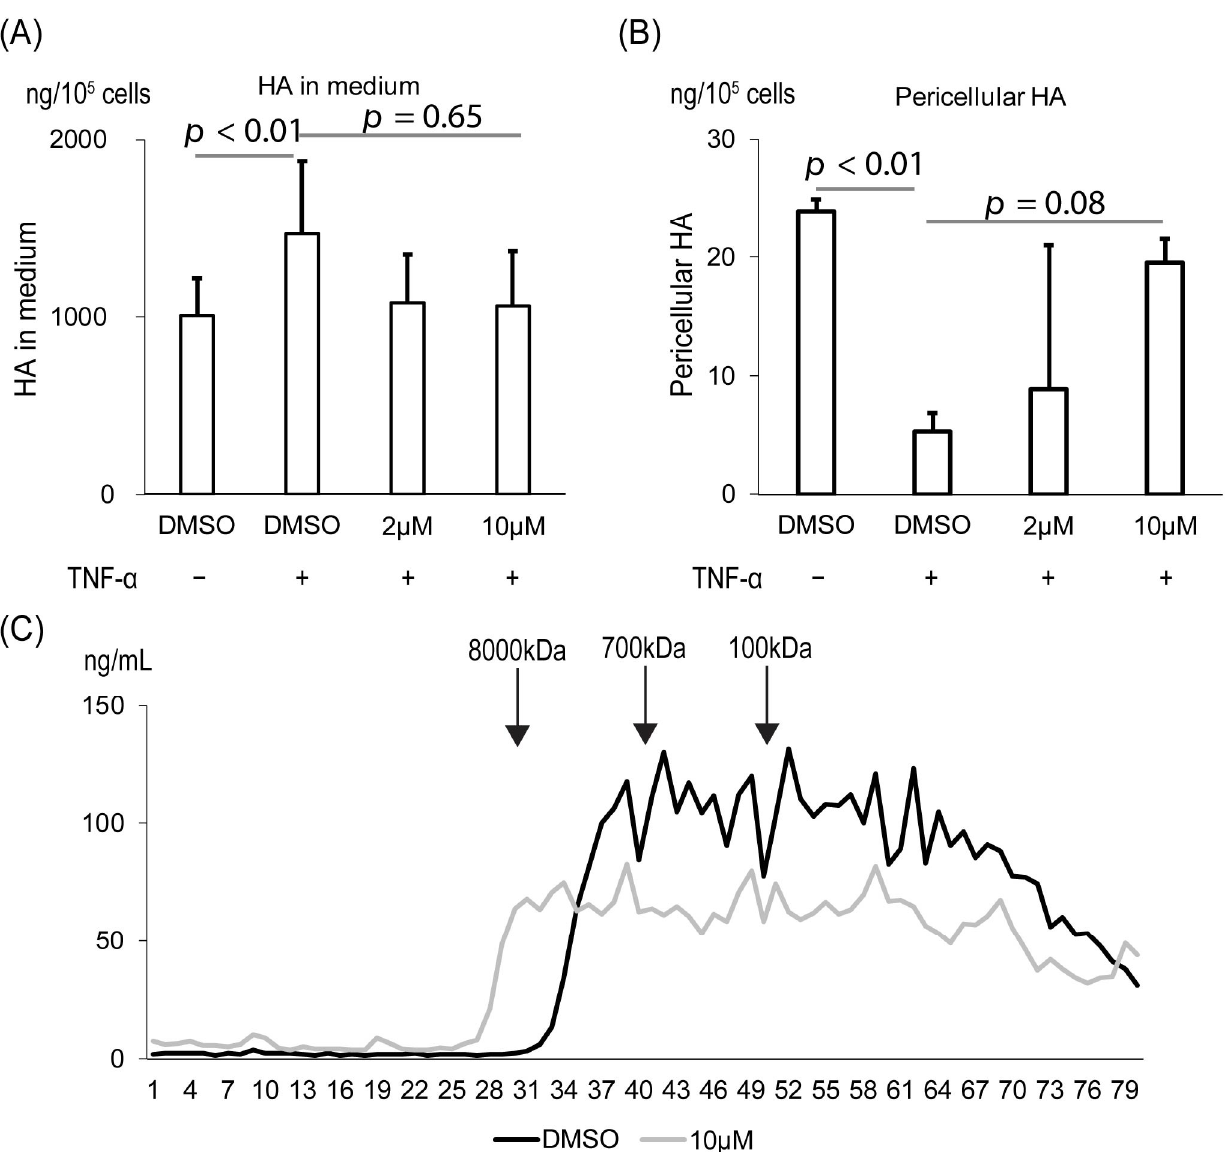
Figure 2. Effects of Ipriflavone on the amount of HA in cultured FLS. ( A , B ) FLS (10 5 cells) was cultured with or without TNF- α and Ipriflavone (2 µ M or 10 µ M). Amount of HA was analyzed in the pool of conditioned medium ( A ) and pericellular area ( B ) by ELISA. ( C ) Molecular size of HA in medium from cells with or without 10 µ M Ipriflavone were analyzed with gel filtration chromatography.